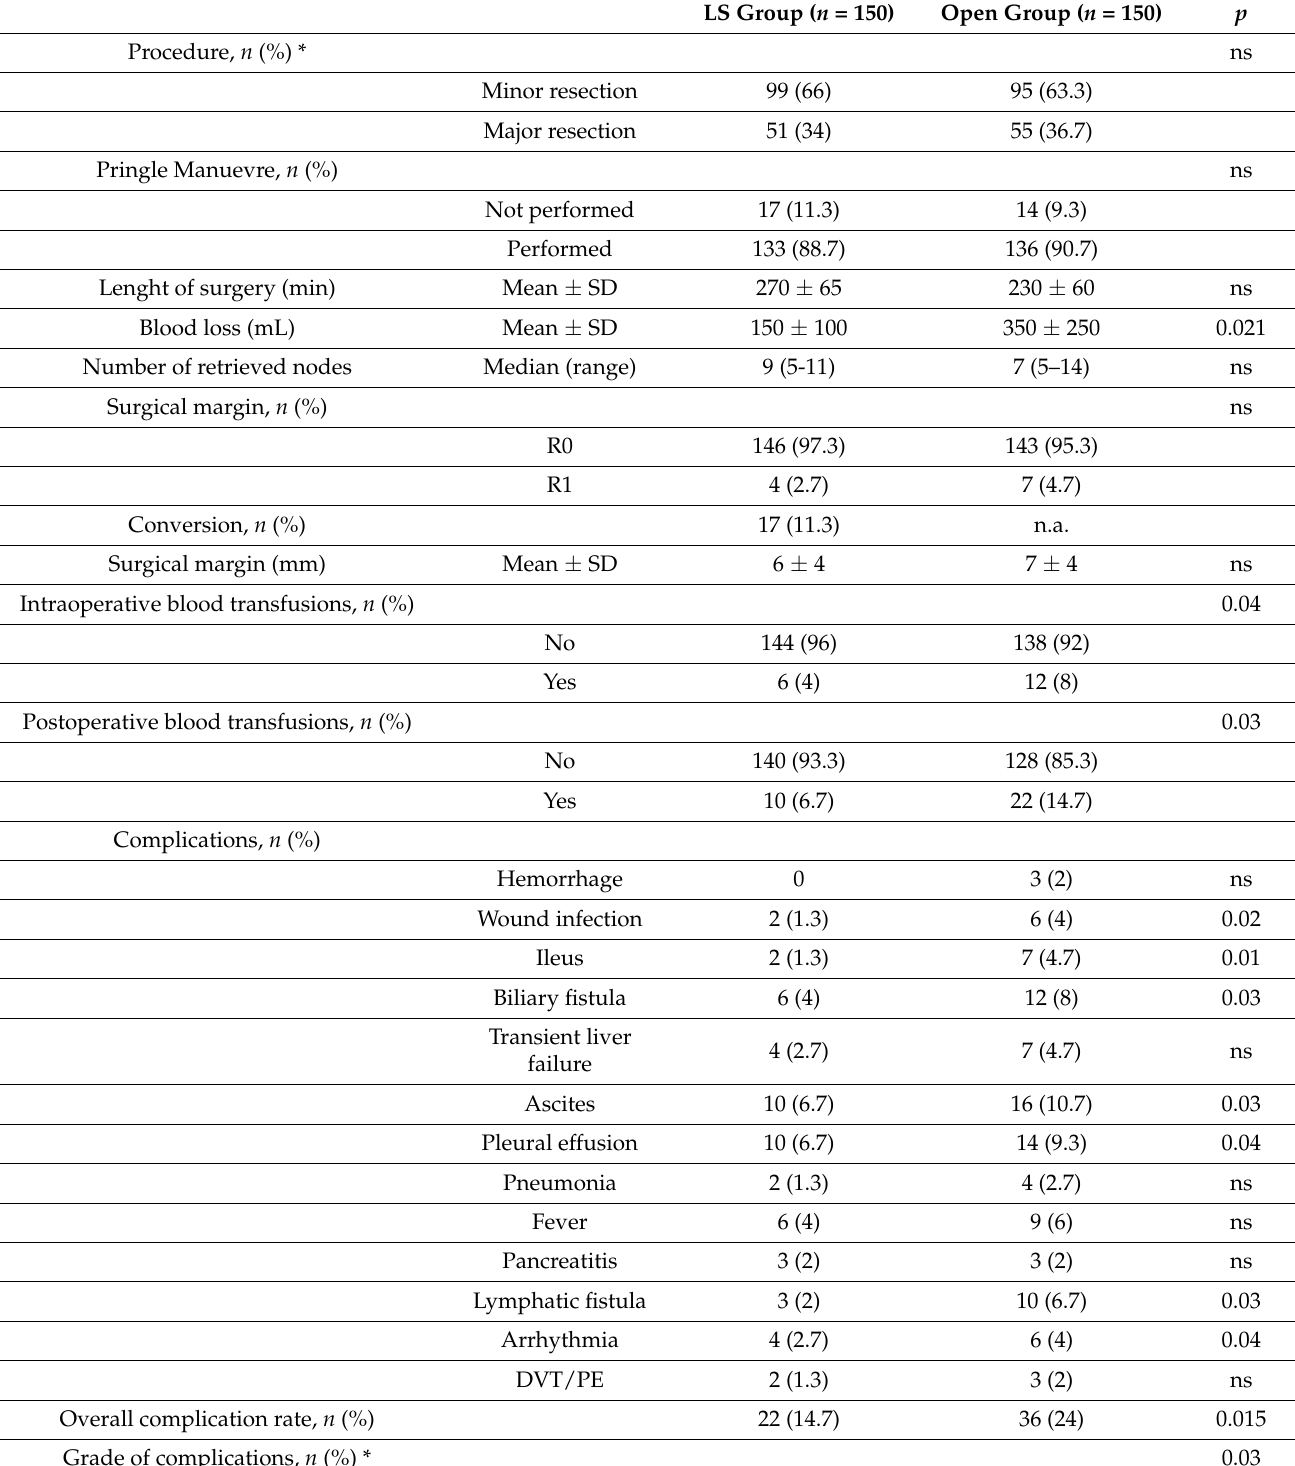
Table 2. Intra- and postoperative details. * Grade of complication was calculated according to the Dindo–Clavien classifica- tion of surgical complications